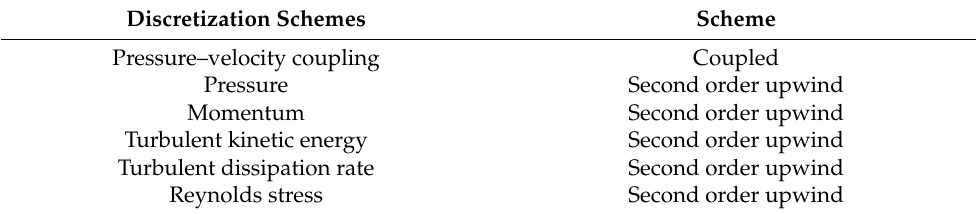
Table 7. Numerical